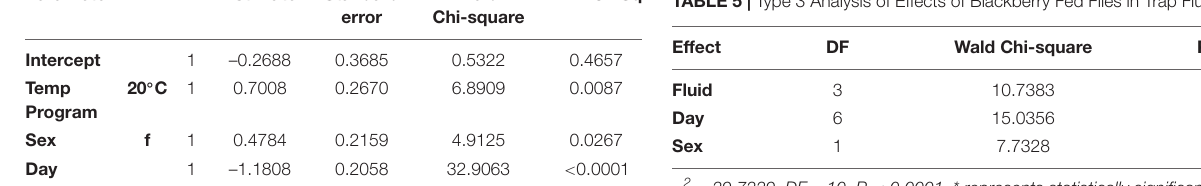
TABLE 5 | Type 3 Analysis of Effects of Blackberry Fed Flies in Trap